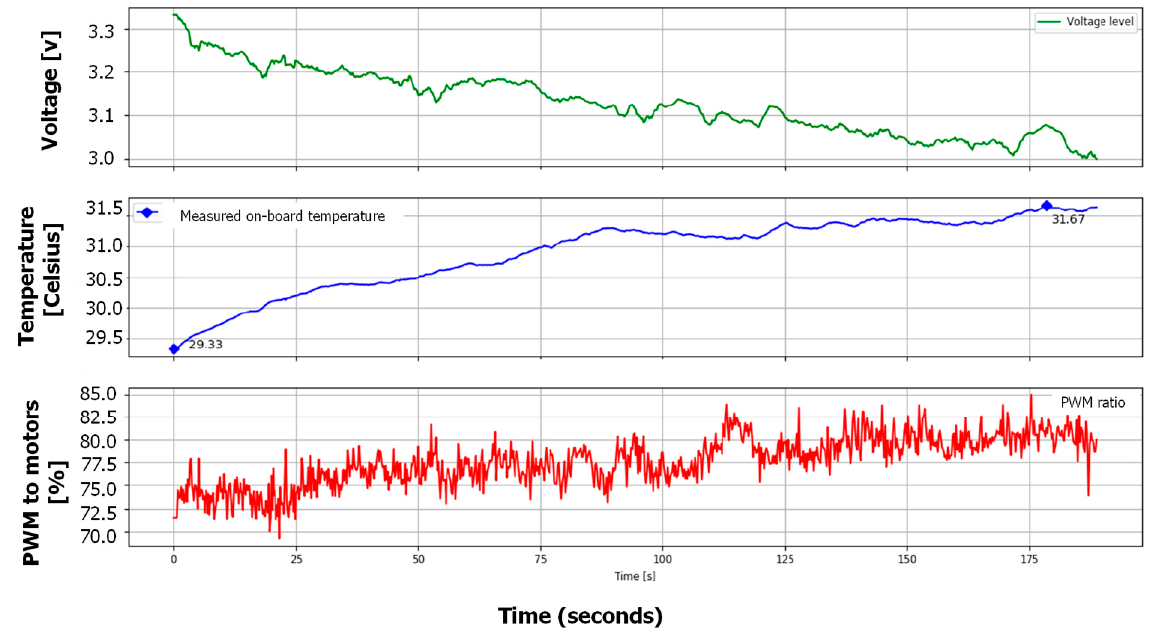
Figure 11. Sensor readings during hover with camera and video transmission module on-board (camera and transmitter (TX) module turned off).